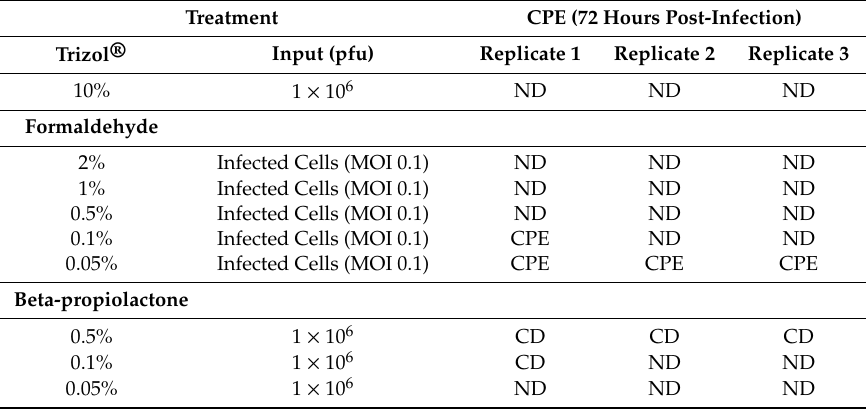
Table 1. Inactivation of SARS-CoV-2 by TRIzol ® , formaldehyde, and beta-propiolactone.